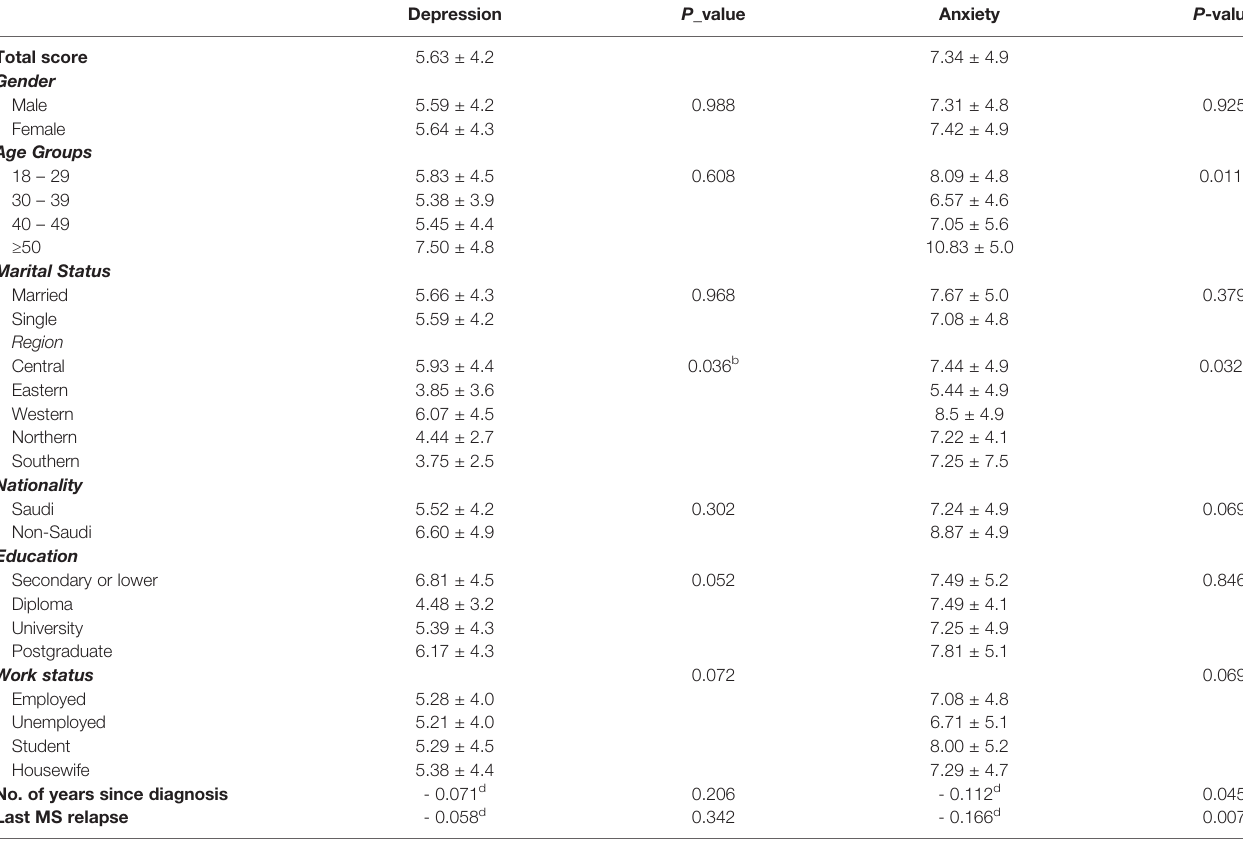
TABLE 2 | Depression and anxiety total mean scores and by demographic